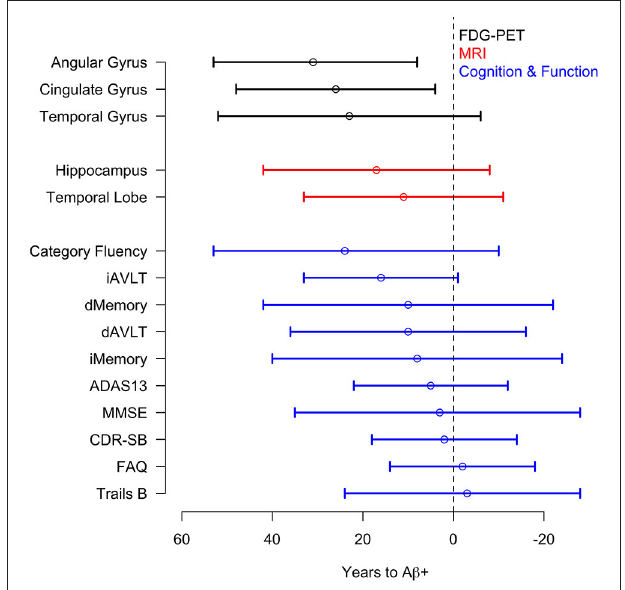
FIGURE 5 | Acceleration point estimates and 95% confidence intervals. Estimates of the initial acceleration points and 95% confidence intervals for all outcomes are plotted against T2A β + . Time to A β -positivity decreases from left to